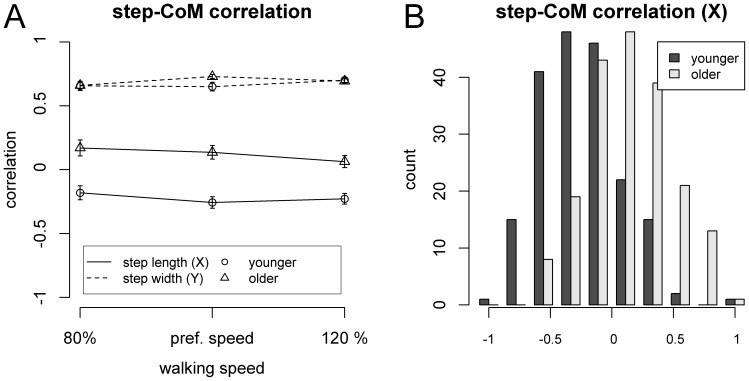
Step-CoM correlations. A.Correlation coefficient, as a function of direction (step length, step width), walking speed, and age group. Error bars represent SEM. B. Histogram of correlation coefficients in the fore-aft (X) direction.